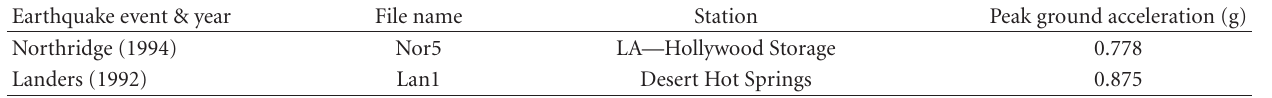
Table 6: Ground motion details of earthquakes used to excite the